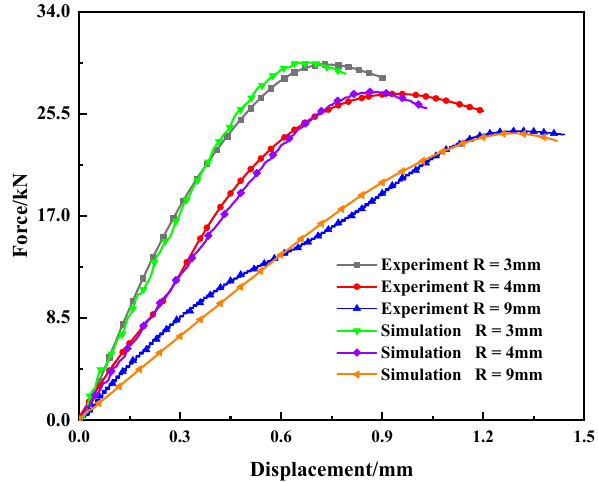
Figure 7. Comparison of load–displacement between simulation and notched bar tensile test results (R = 3, 4, 9 mm).